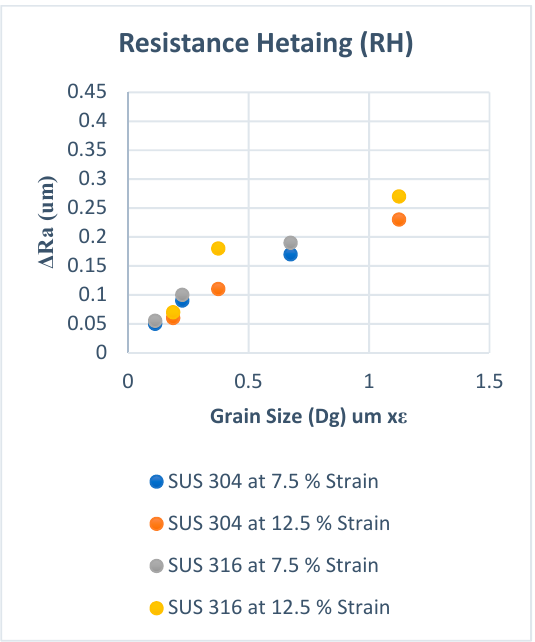
Figure 11. Δ Ra versus Dg × ε at resistance heating (RH) . Figure 11. ∆ Ra versus Dg × ε at resistance heating (RH).